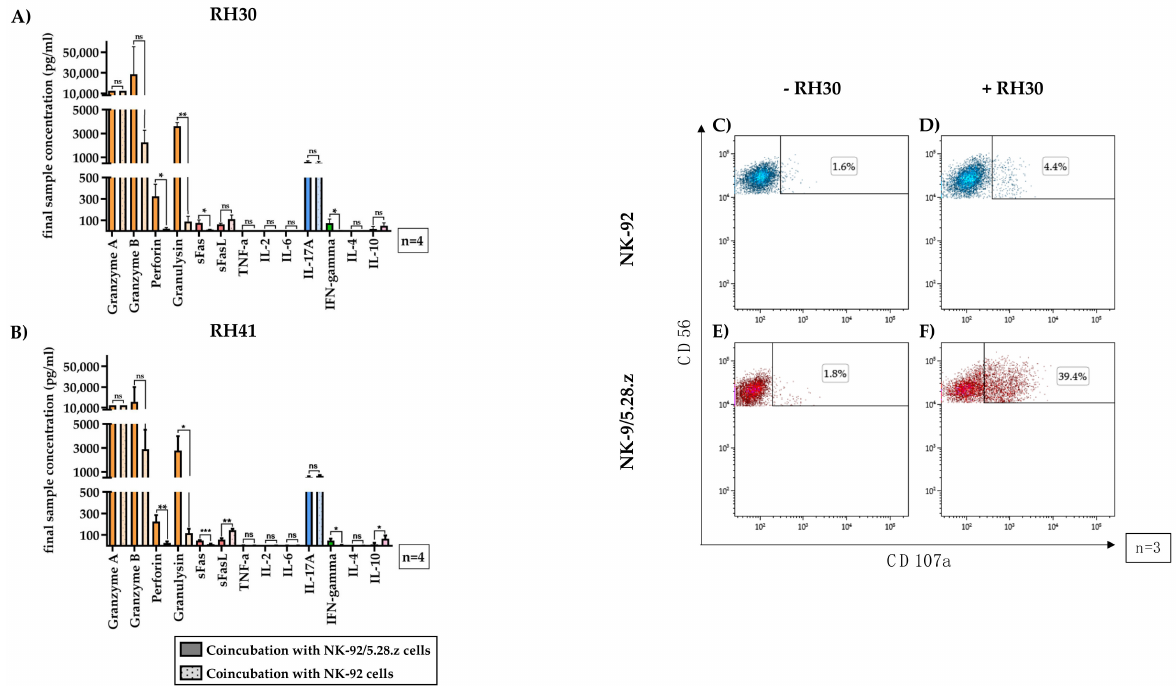
Figure 6. Secretion of immunoregulatory factors by activated NK-92/5.28.z cells. The supernatants of cocultures of RH30 ( A ) and RH41 ( B ) cells with NK-92/5.28.z and NK-92 cells at E:T ratios of 20:1 (absolute cell count per well: 1 × 10 5 effector cells and 5 × 10 3 target cells) were assessed for effector molecules and immunoregulatory factors. Mean concentrations are shown ± SD. The lytic molecules granzyme A and B, perforin and granulysin (orange bars), interleukin (IL)-17A (blue bars), interferon (IFN)- γ , and Fas ligand (FasL) (red bars) were detectable at increased concentrations in NK-92/5.28.z compared with NK-92 cocultures. Cocultures with NK-92 cells showed higher levels of FasL (red bars) and IL-10 (purple bars) than cocultures with NK-92/5.28.z cells. Tumor necrosis factor (TNF)- α , IL-2, IL-4, and IL-6 were not secreted at considerable levels. To assess their degranulation capacity, NK-92 ( C , D ) or NK-92/5.28.z cells ( E , F ) were coincubated with RH30 cells ( D , F ) or remained without target cells ( C , E ). Cells stained with CD107a and CD56 antibodies represented degranulating immune effector cells. Differences were considered significant for p < 0.05 (*), p < 0.01 (**), p < 0.005 (***), or not significant